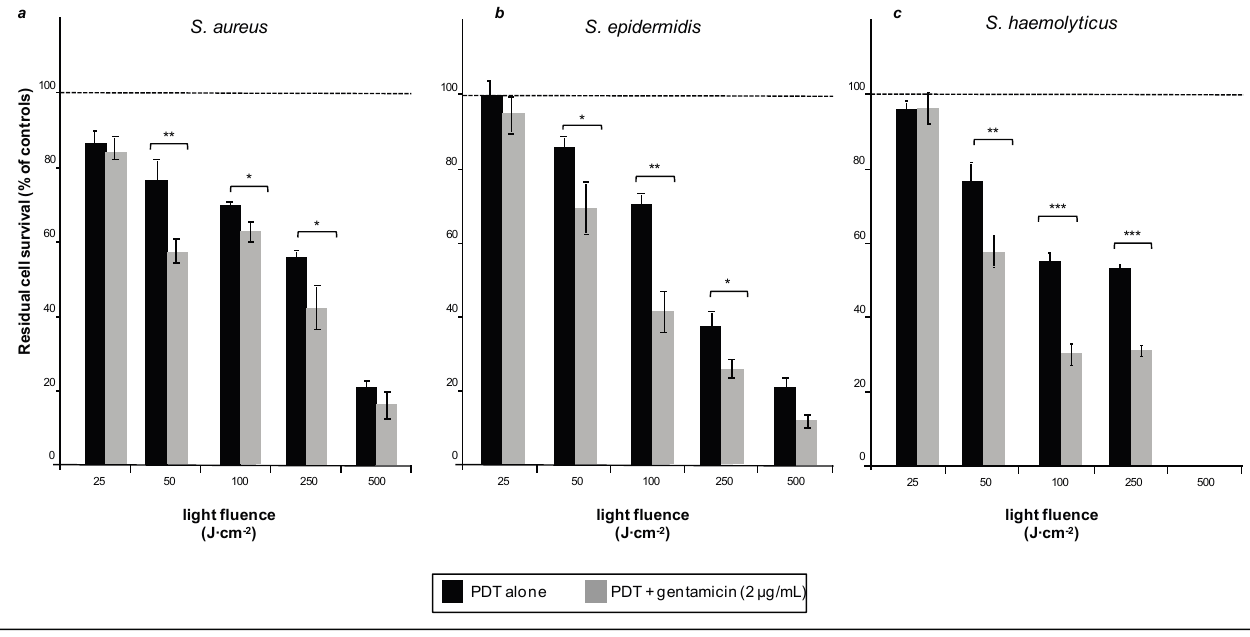
Figure 2. Biofilms of S. aureus ( a ), S. epidermidis ( b ) and S. haemolyticus ( c ) all incubated with 5-ALA and exposed to red light only (black bars) or light and Gentamicin in combination (grey bars). The dotted bar is referred to each respectively control